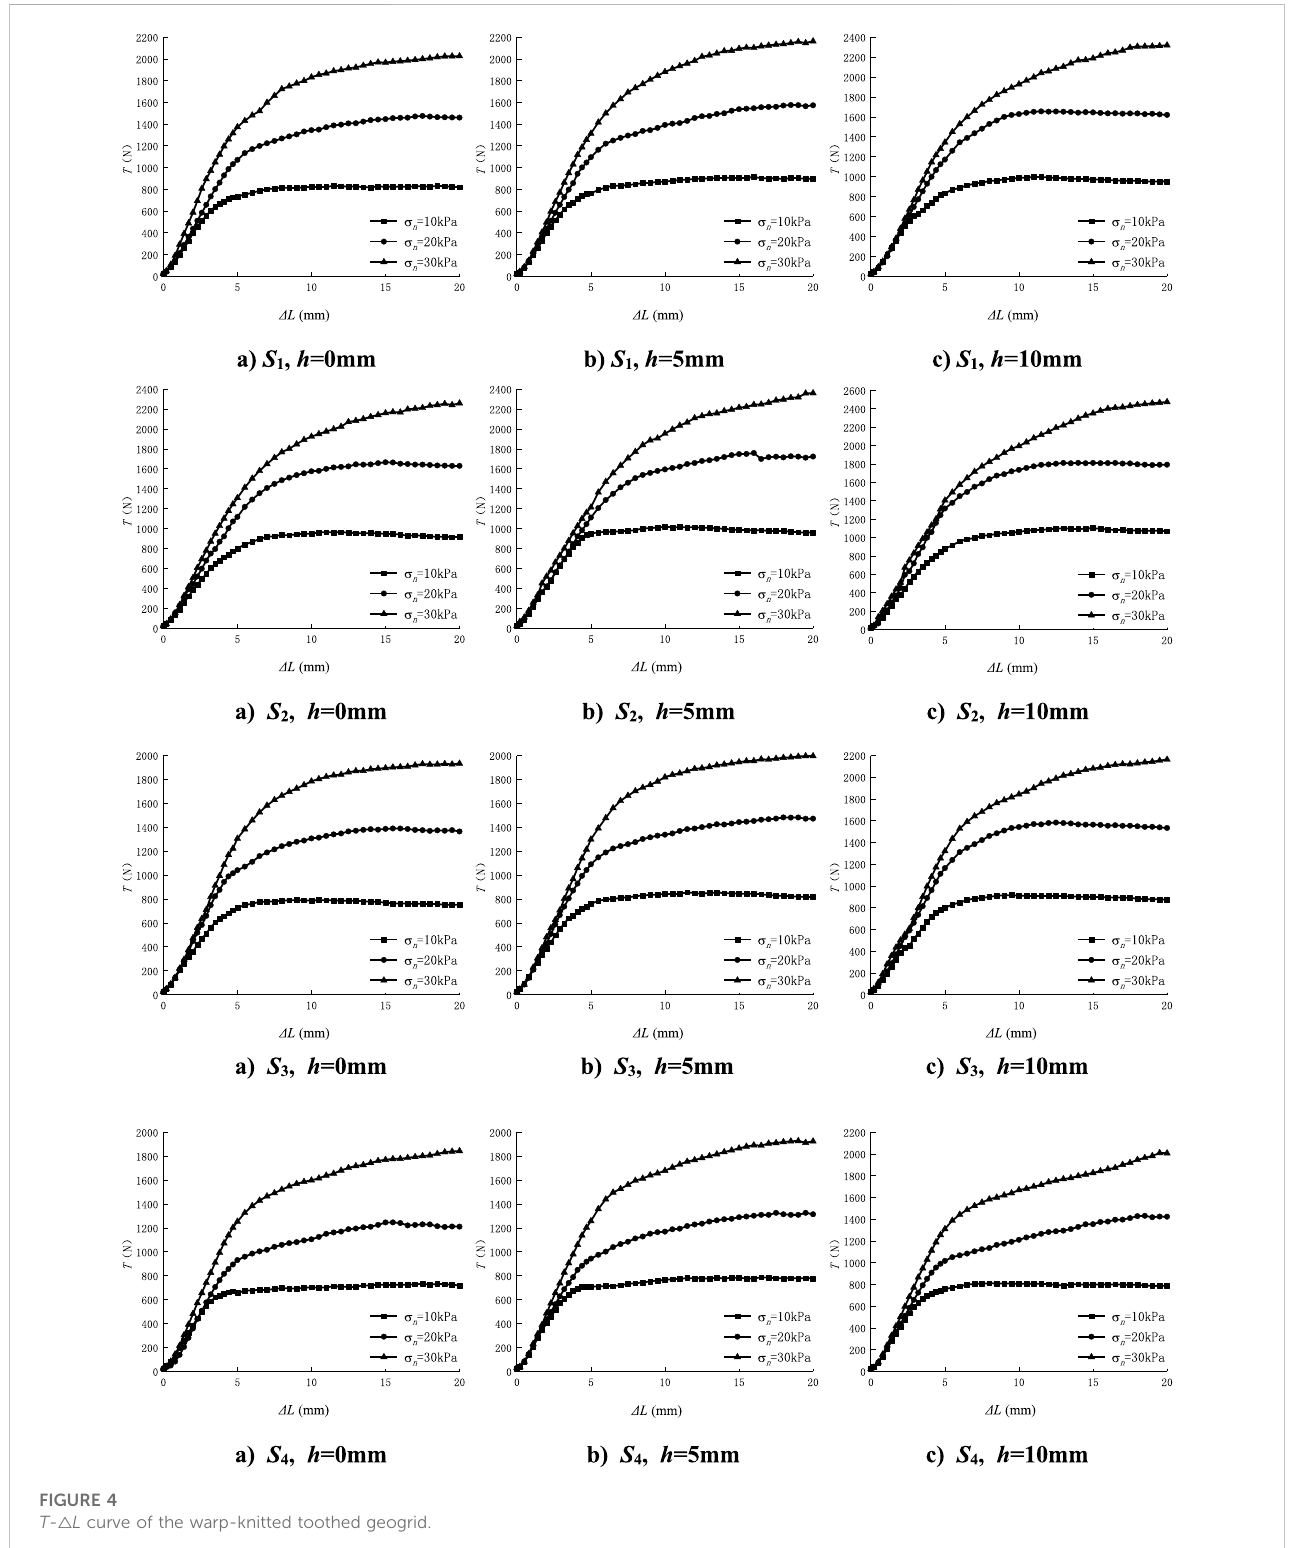
FIGURE 4 T - △ L curve of the warp-knitted toothed geogrid.